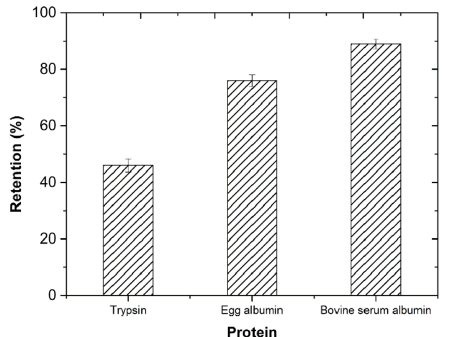
Figure 6. Retention of ceramic tubular membranes for different proteins.